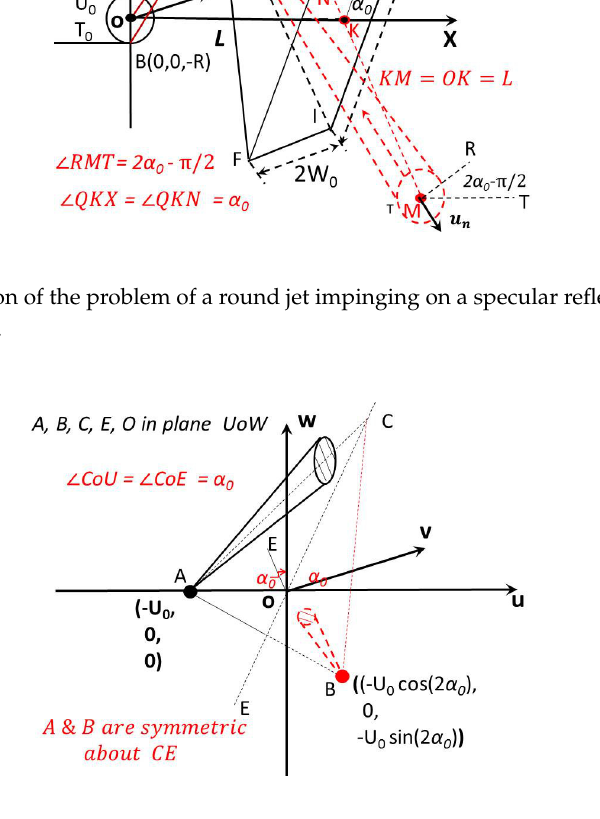
Figure 14. Velocity phases for the specular reflective plate impingement problem. Solid cone: for the free jet; dashed red cone: reflected